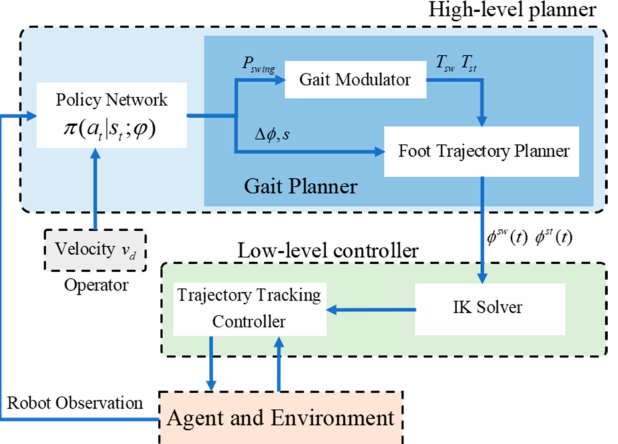
Figure 3. Gait generation and motion control architecture based on reinforcement learning and modular hierarchical framework. This architecture decouples the planning and motion control problem of a hexapod robot into two levels, including a motion planner (shown in blue) and joint trajectory controller (shown in green).